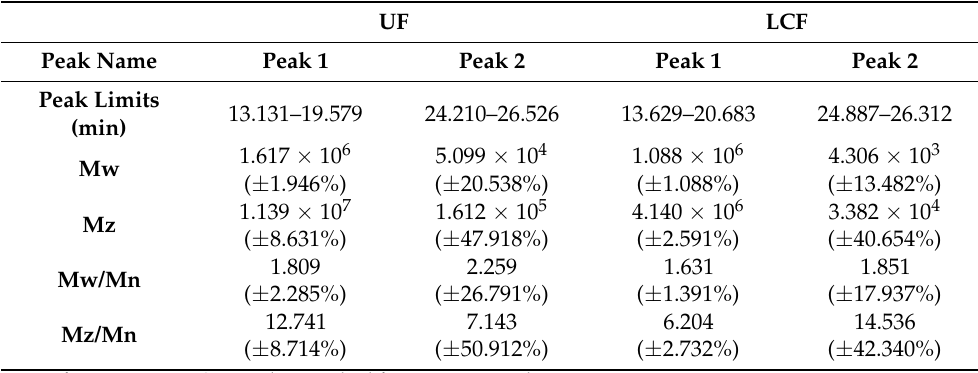
Table 3. Distribution of molecular weights of polysaccharides in UF and